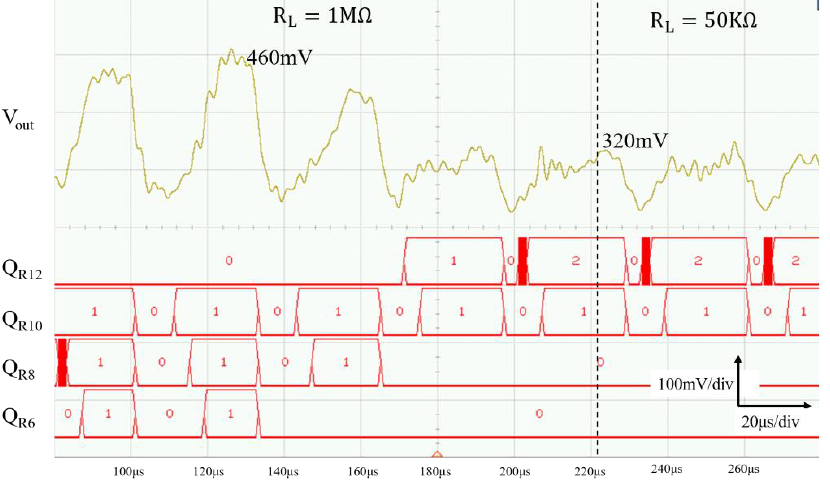
Figure 10. Measurement output of Vout when Pin is −19 dBm while the loading varied from 1 MΩ to 50 kΩ.